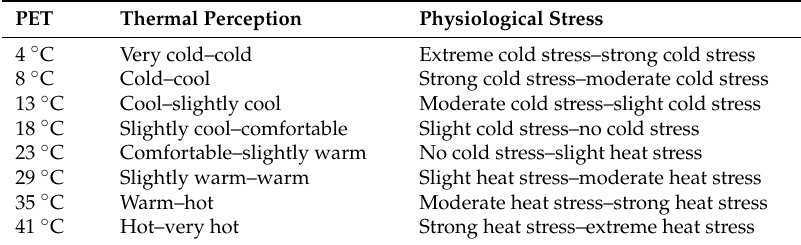
Table 7. Ranges of PET.